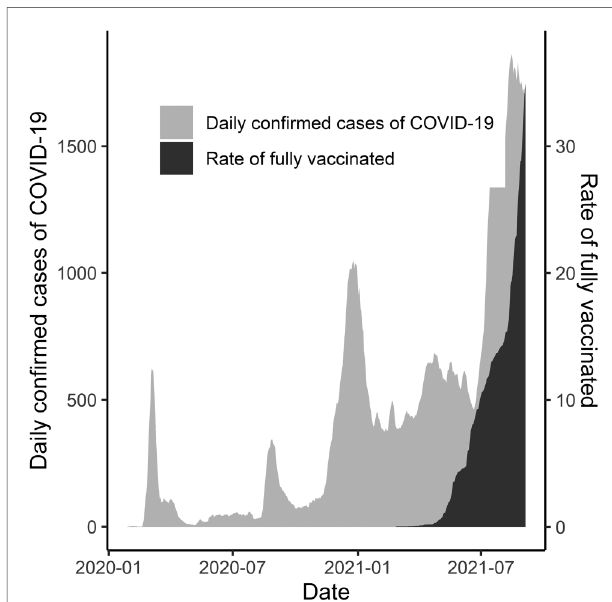
FIGURE 2 | Daily con fi rmed cases of COVID-19 and percentage of fully vaccinated individuals until August 31, 2021.